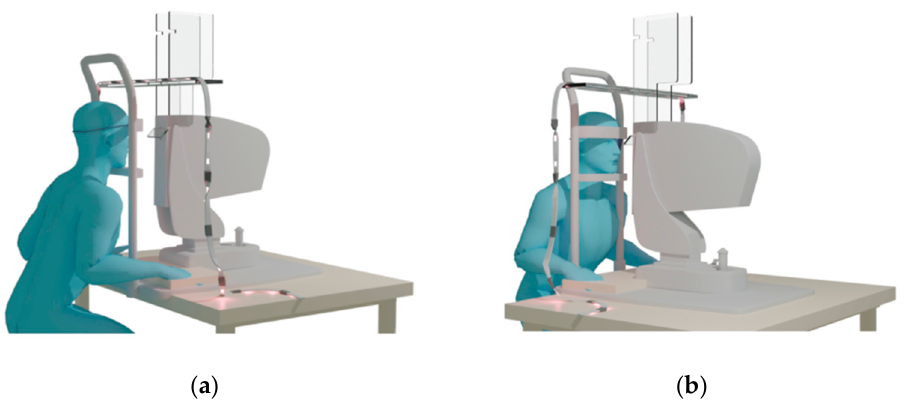
Figure 1. A 3D representation of the experimental design: ( a ) Lateral-posterior view; ( b ) Lateral- frontal view.